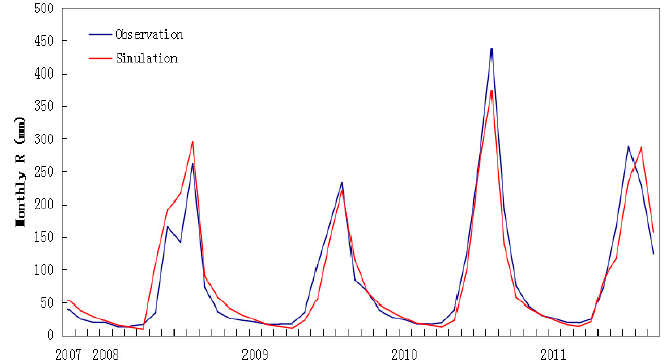
Figure 8. Observed precipitation, temperature, and discharge and discharge generated by the Hydrologiska Byrans Vattenavdelning (HBV) model during 2007/2008–2010/2011 (calibration periods: 2007/2008 ( a ), 2008/2009 ( b ); validation periods: 2009/2010 ( c ), 2010/2011 ( d )).